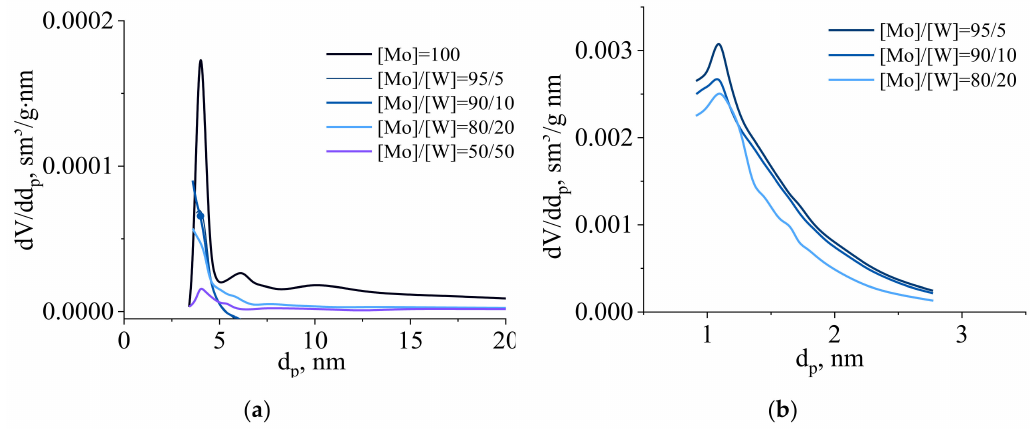
Figure 8. ( a ) Meso- and ( b ) micropore distribution of binary carbides, synthesized molybdenum-tungsten blue xerogels (calcined at 900 ◦ C in inert atmosphere) with di ff erent ratios [Mo] / [W] and constant molar ratio [R] / [ Σ Me] =